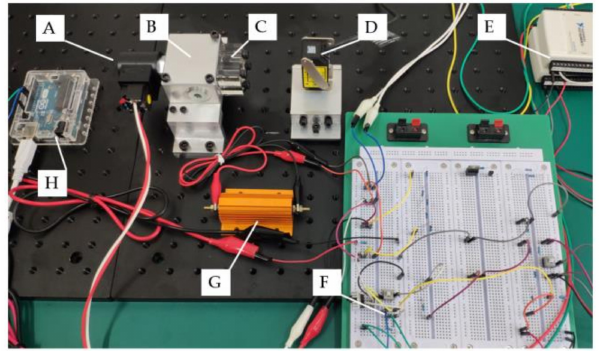
Figure 6. Photo of valve spool optical measurement system: A: Solenoid on–off valve; B: Aluminum valve manifold; C: Acrylic sight window (only installed during oil-immersed experiment); D: Laser triangulation sensor; E and F: Data acquisition and control; G: High-power electrical resistance; H: Micro-controller